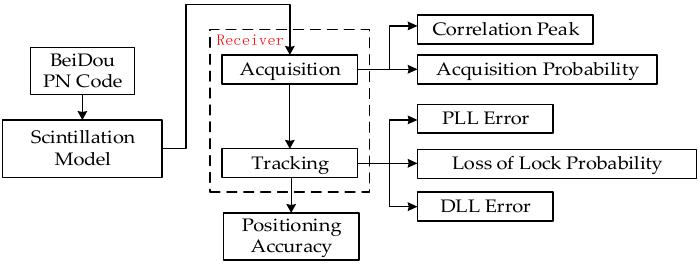
Figure 7. Analysis Figure 7. Analysis method. Figure 7. Analysis method.